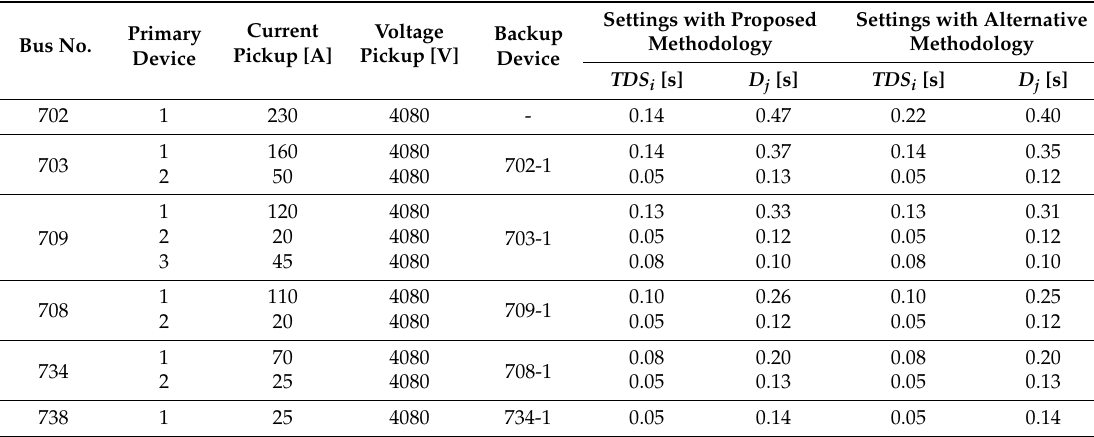
Table 1. Obtained results of modified IEEE 37-node